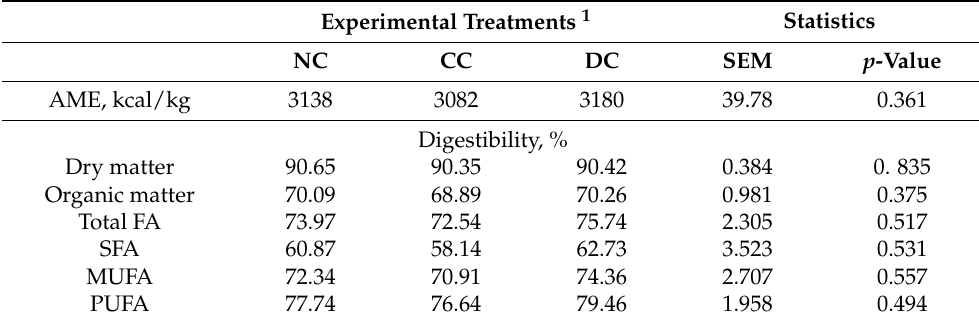
Table 11. Effects of treatments on dietary AME (kcal/kg) along with dry matter, organic matter, and fatty acid digestibility (%) in 11-day-old broiler chickens (Experiment